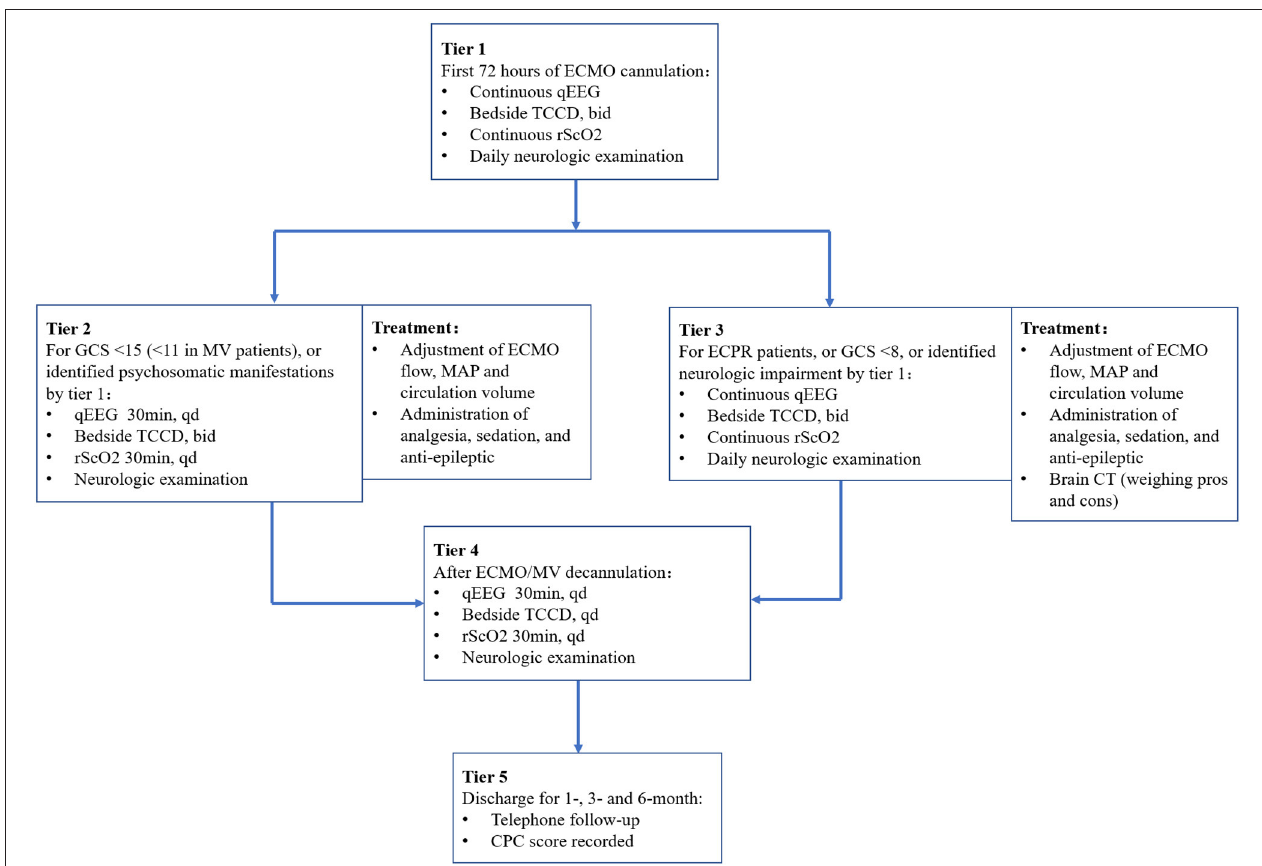
FIGURE 2 | Diagram of the MNM-guided protocol. ECMO, extracorporeal membrane oxygenation; qEEG, quantitative electroencephalogram; TCCD, transcranial color Doppler ultrasonography; rScO 2 , regional cerebral oxygenation; GCS, Glasgow Coma Scale; MAP, mean arterial pressure; CT, computed tomography; MV, mechanical ventilation; CPC, cerebral performance category; bid, bis in die; qd, quaque